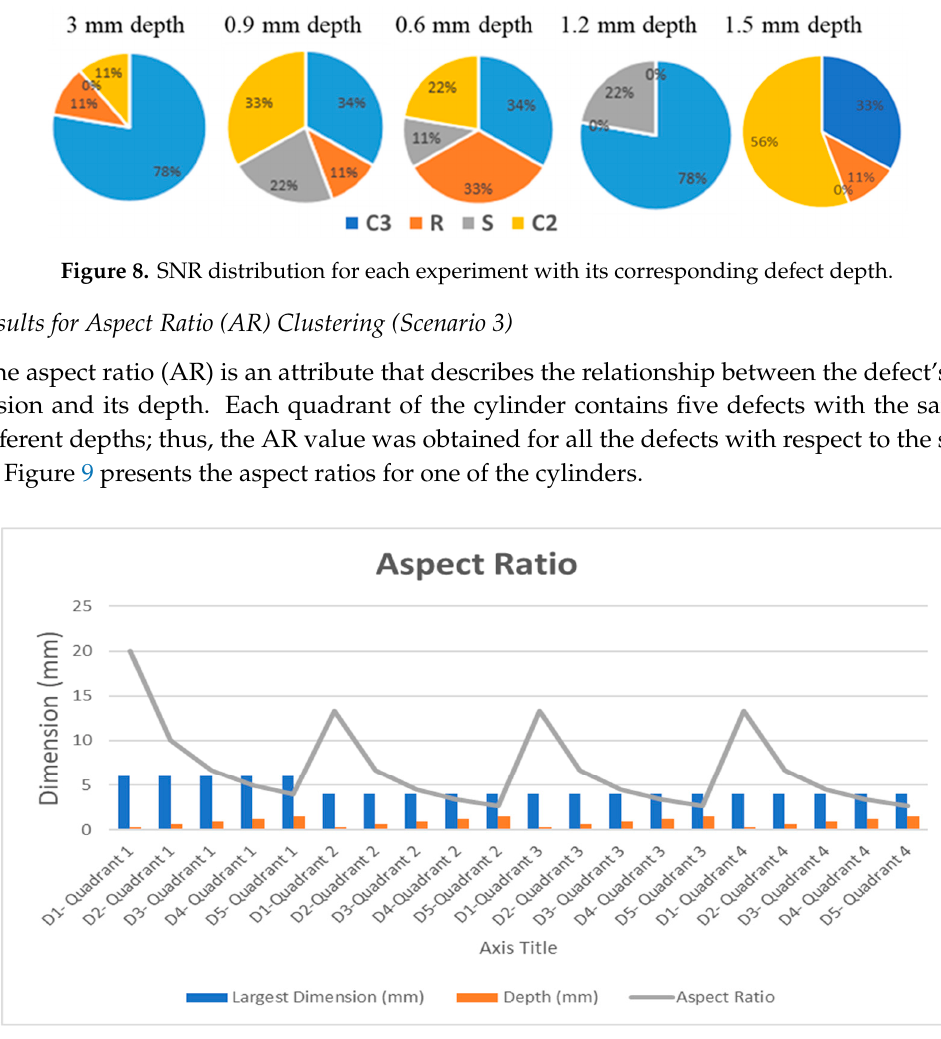
Figure 9. Aspect Ratio Calculations for one cylindrical sample.